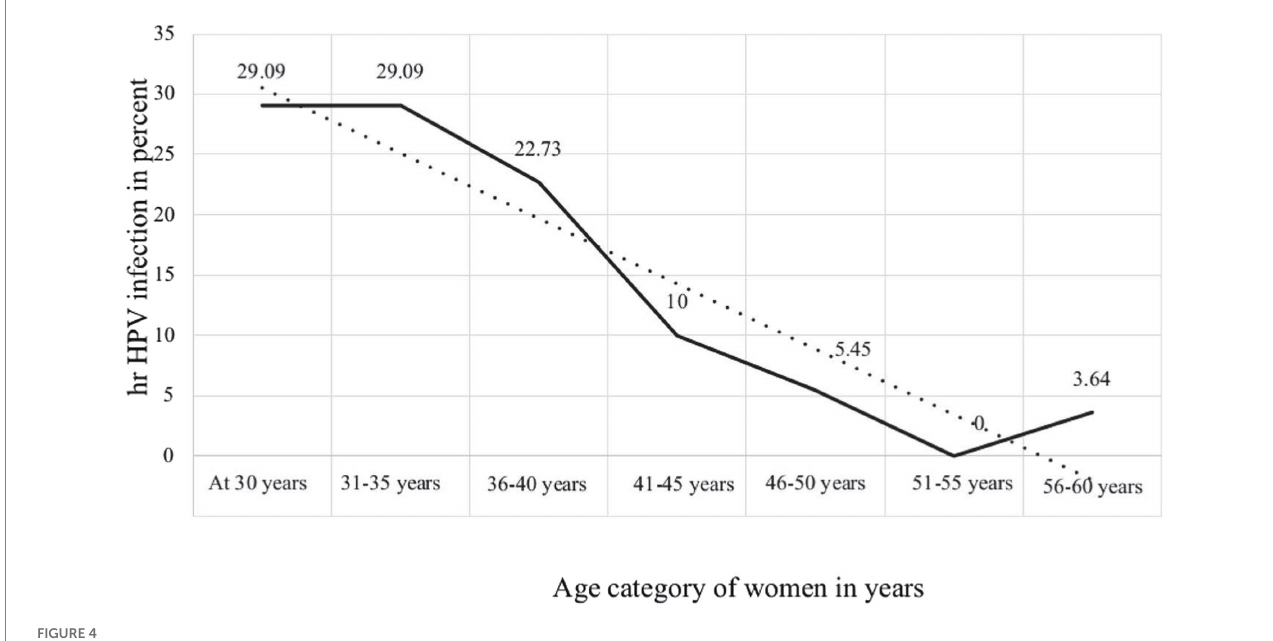
FIGURE 4 Age-specific prevalence of hr HPV infection among women in Ethiopia.